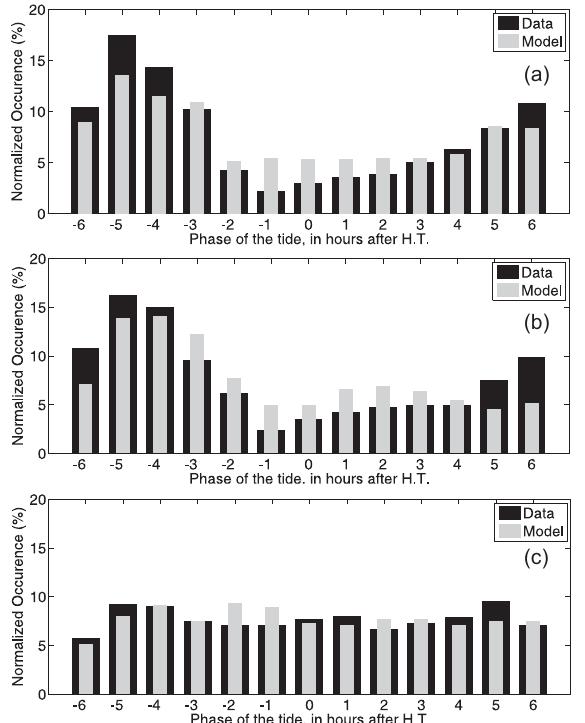
Fig. 2. Occurrence ( % ) of the 1 % highest observed (black) and modelled (grey) hourly storm surges versus the tidal phase, in hours after high-tide (h) for: (a) Dunkerque, (b) Saint-Malo, (c) Le Conquet. The calculation is performed over the period 2003-2009. The 99th percentile (corresponding to the thresholds of the 1 % highest storm surges) are (0.65;0.54), (0.43;0.37),(0.37;0.33), in meter, respectively for each tidal gauge location (a,b,c), with the first value corresponding to the data processing, and the second, to the processing of the model results.